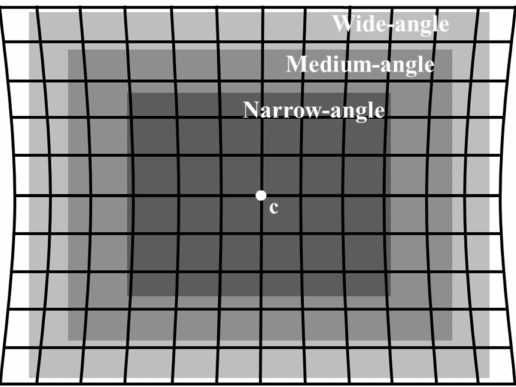
Figure 5. The distortion ratio according to the di ff erent angles of the image.